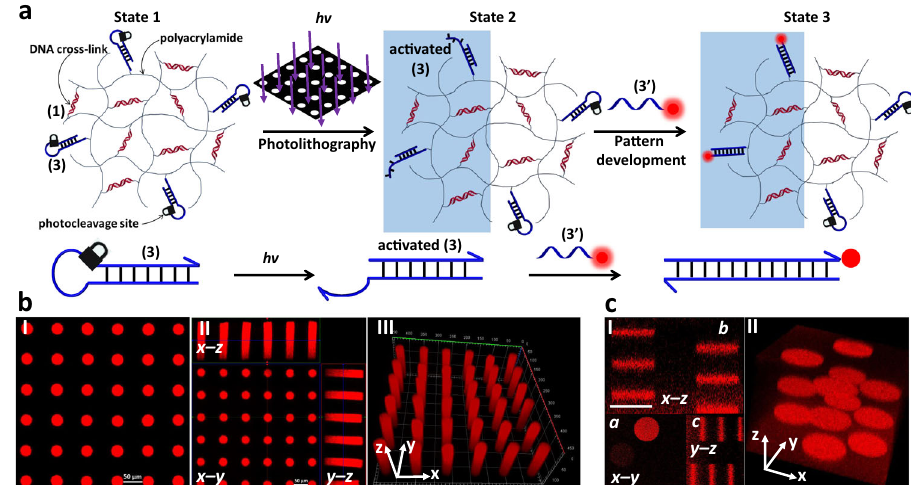
Fig. 3 Light-induced patterning and imaging of a photoresponsive polyacrylamide hydrogel fi lm functionalized with (1) and the o- nitrobenzylphosphate ester photocleavable hairpin (3). a Photolithographic patterning of the hydrogel through a circular hole-containing mask ( λ = 365 nm), and the fl uorescence imaging of the resulting pattern by the hybridization of TAMRA labeled (3 ’ ) to the activated (3) tethers associated with the irradiated domains. b Panel I — Fluorescence confocal microscope imaging of the patterned hydrogel. Panel II — Three-dimensional confocal microscope imaging of the hydrogel fi lm across the x-y, x-z, and y-z planes. Panel III – Fluorescence confocal microscope imaging of the reconstructed three- dimensional patterned hydrogel. Scale bar lengths 50 μ m. c Fluorescence confocal microscope imaging of twelve layered circular domains generated by two-photon laser scanning confocal microscope photopatterning process ( λ = 740 nm) using different spatial and positional focusing depths. Panel I — Confocal microscope imaging of the two-photon laser patterned hydrogel fl uorescence images recorded along the x-y plane ( a ), the x-z plane ( b ) and the y-z plane ( c ). Panel III – Confocal microscope imaging of reconstructed three-dimensional patterned hydrogel that includes twelve patterned discs in rectangular con fi gurations along the x-y-z axes. Scale bars correspond to 20 μ m. N = 4 independent experiments were